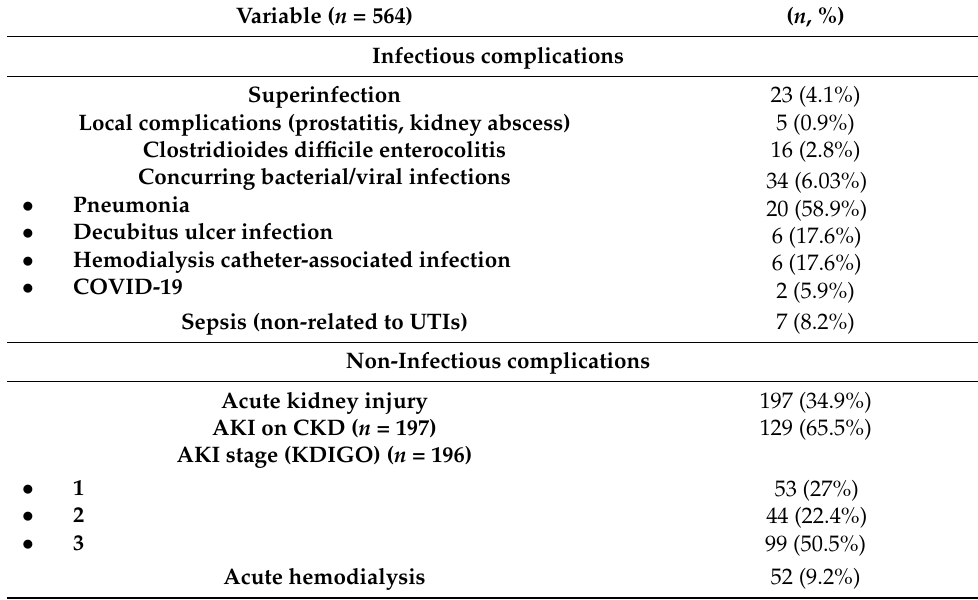
Table A1. Infectious and non-infectious complications during hospital